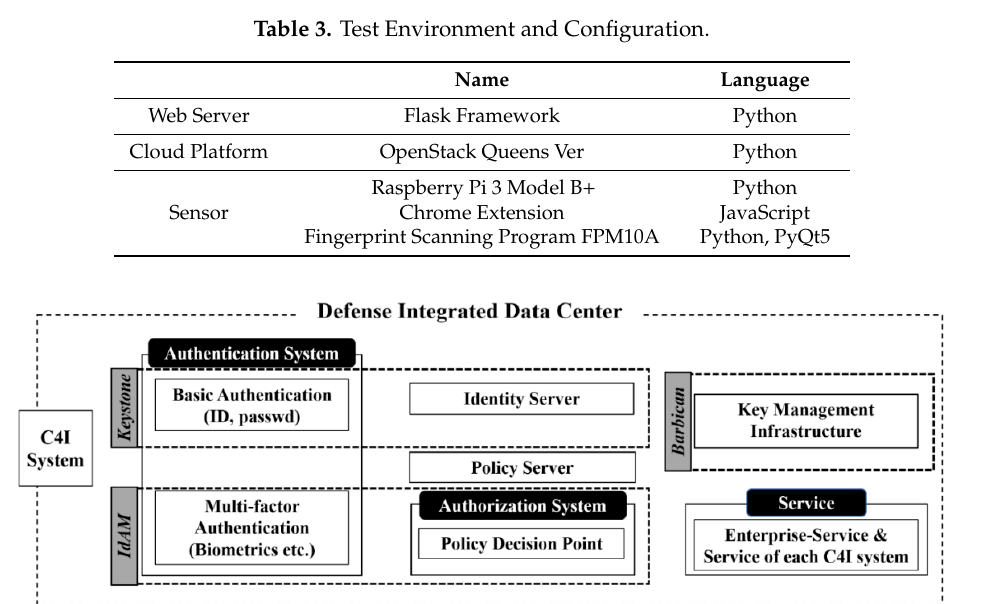
Figure 7. Authentication and Access Control Function in OpenStack C4I system.